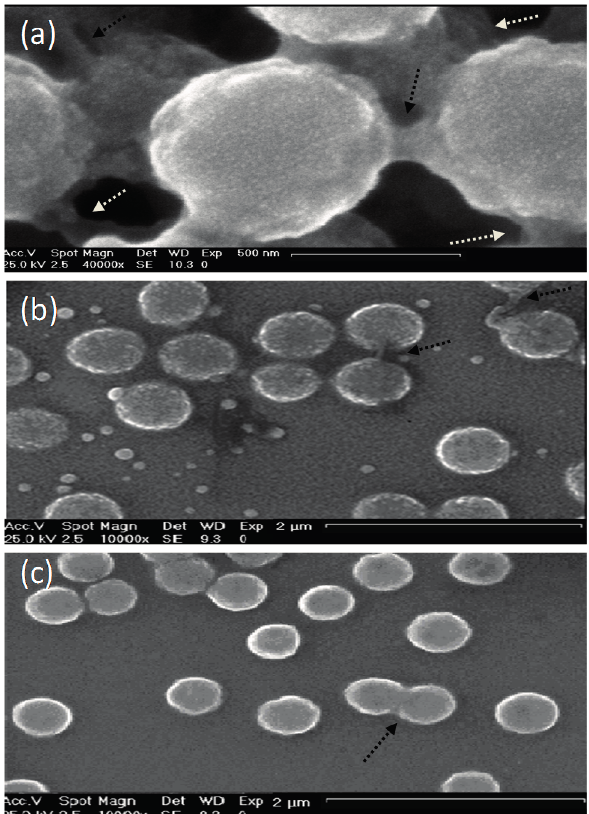
Figure 1. Typical environmental scanning electron microscopy (ESEM) micrographs of: ( a ) bare NG; ( b ) NG/(PLL/PGA) and ( c ) NG/(CHIT/dextran sulfate (DEXS)) in the hydrated state. Reproduced with permission from [8], copyright 2010,